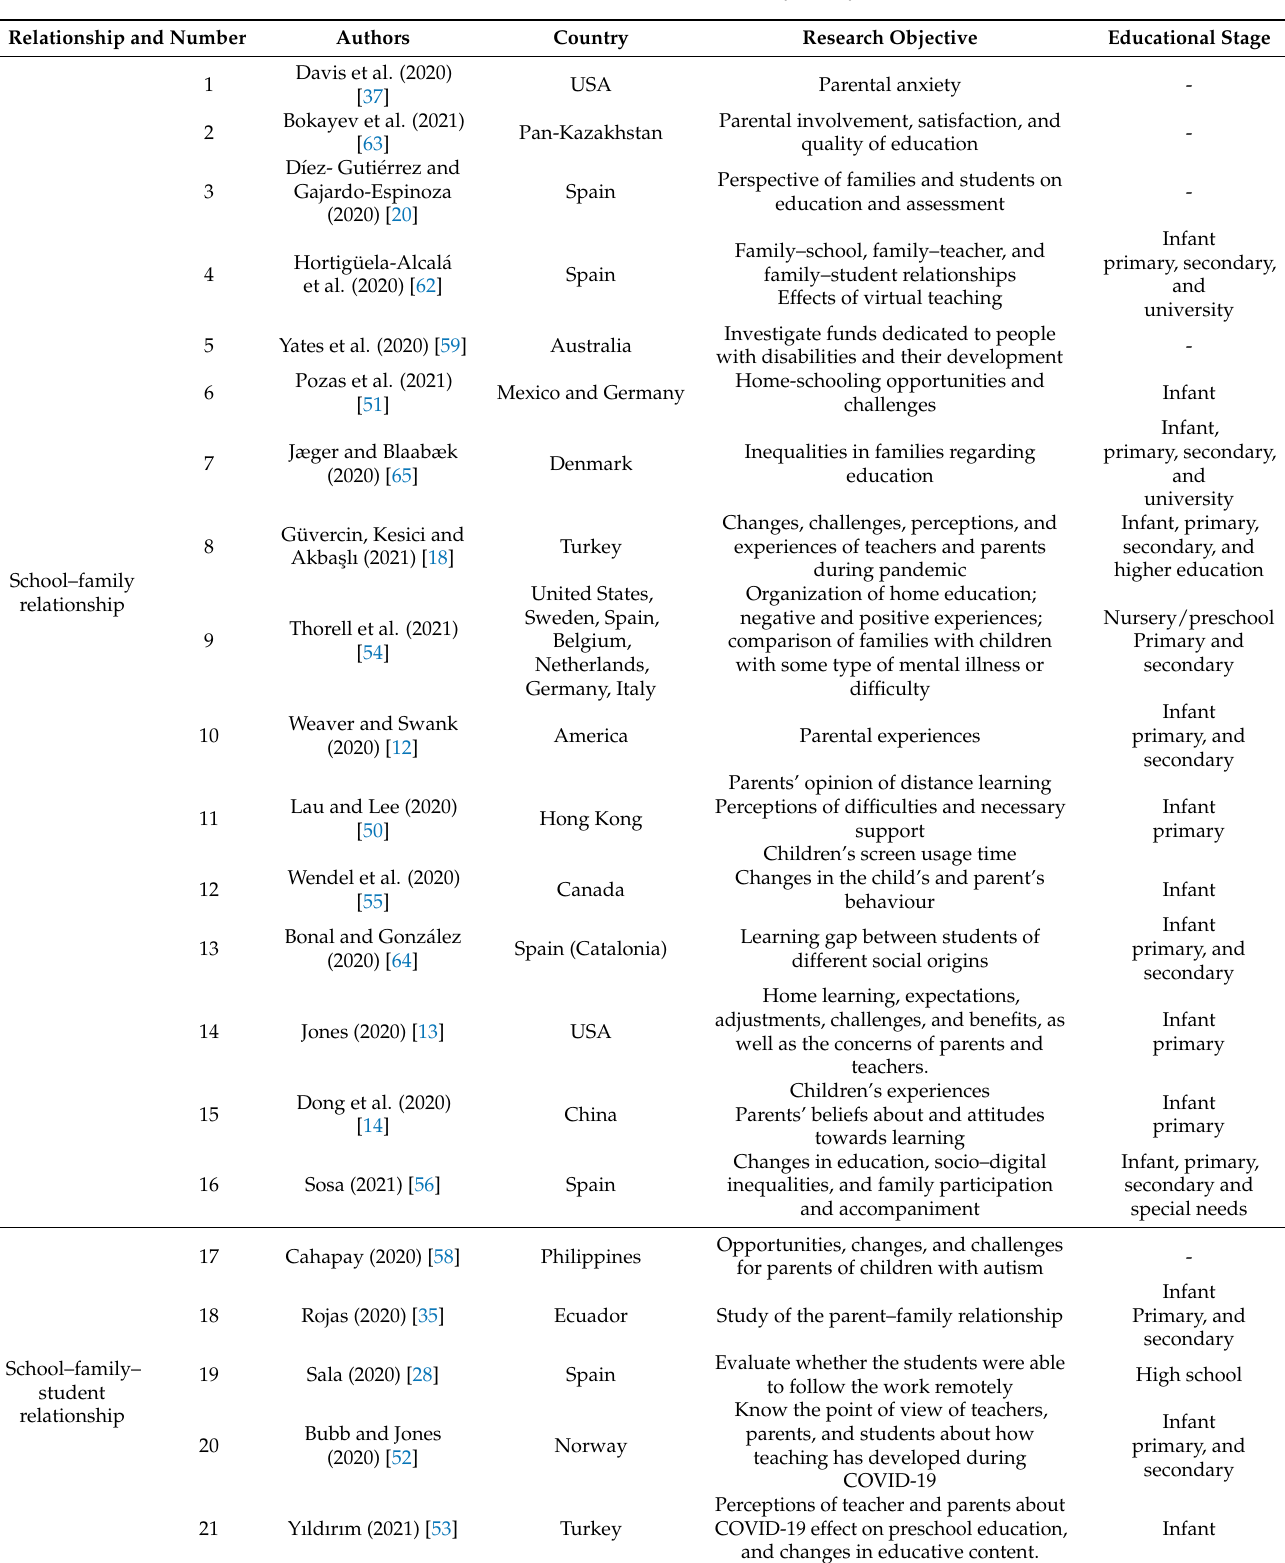
Table 2. List and characteristics of articles selected by the systematic